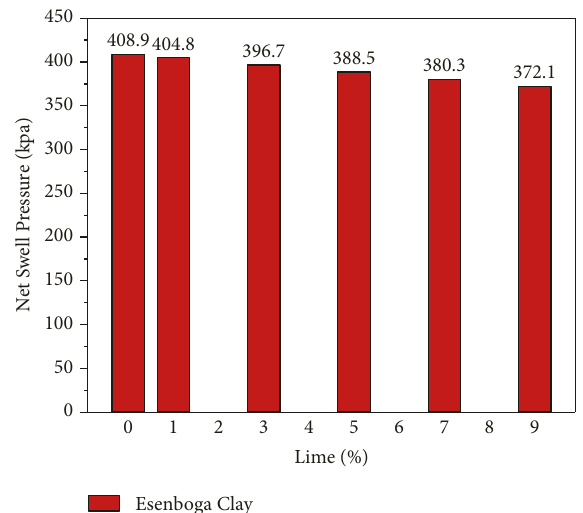
Figure 8: Variation in the net swelling pressure with the lime